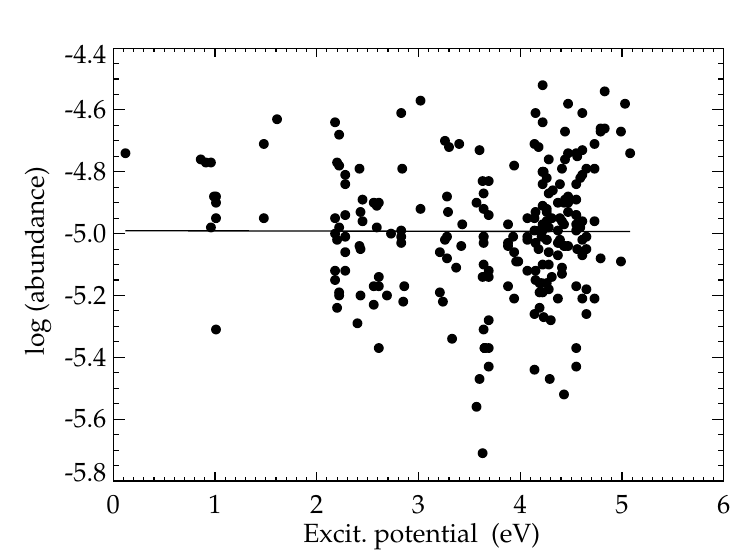
Fig. 2. Dependence of the iron abundance on Fe I line lower excitation potential. The plot corresponds to a microturbulent velocity of 4.0 km s − 1 and T eff = 4500 K. gravity log g = 0 : 0 is nearly correct with the error (cid:20) 0.2. If we accept a larger value of (cid:24) t = 4 : 7 km s − 1 , which seems to fit the Fe II lines better, then the abundances of Fe I and Fe II